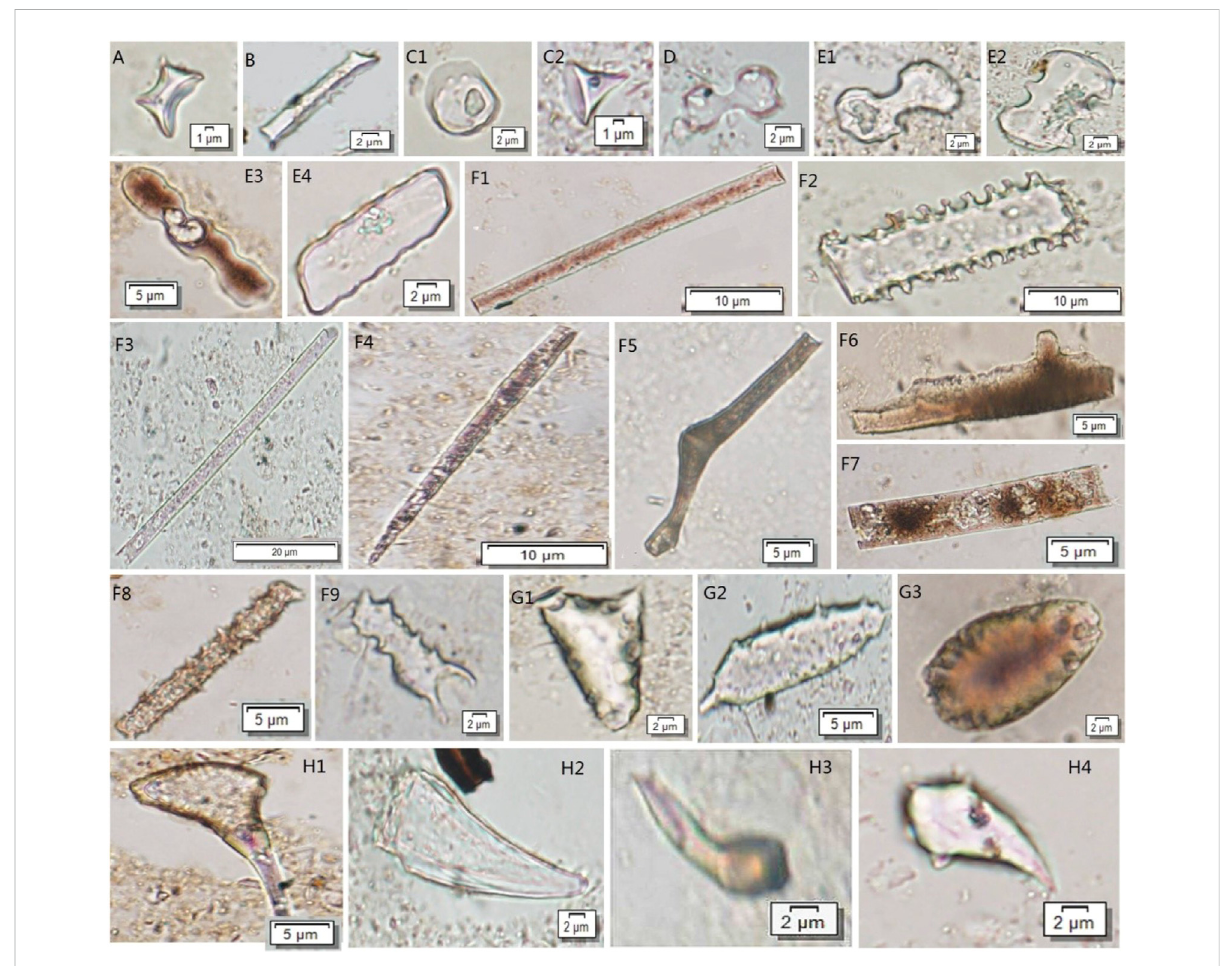
The phytolith morphology types from the ZZH pro fi le in the Badain Jaran Desert. Saddles (A,B) ; rondels (C1,C2) ; dumbbells (D) ; wavy (E1 – E4) ; elongated (F1 – F9) ; short points (G1 – G3) ; long points (H1 – H4)